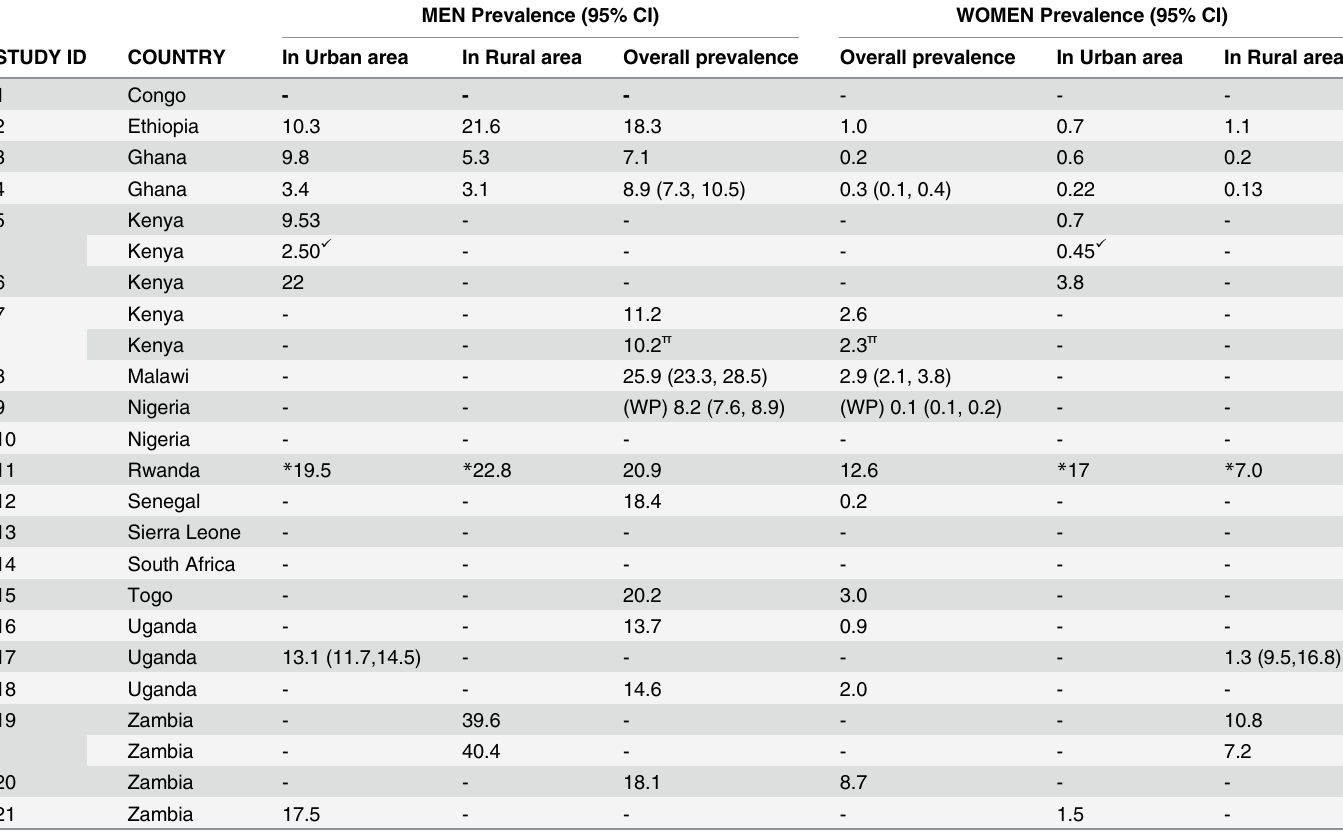
Table 4. Prevalence (95% CI) of current smoking by gender and urban and rural locations where